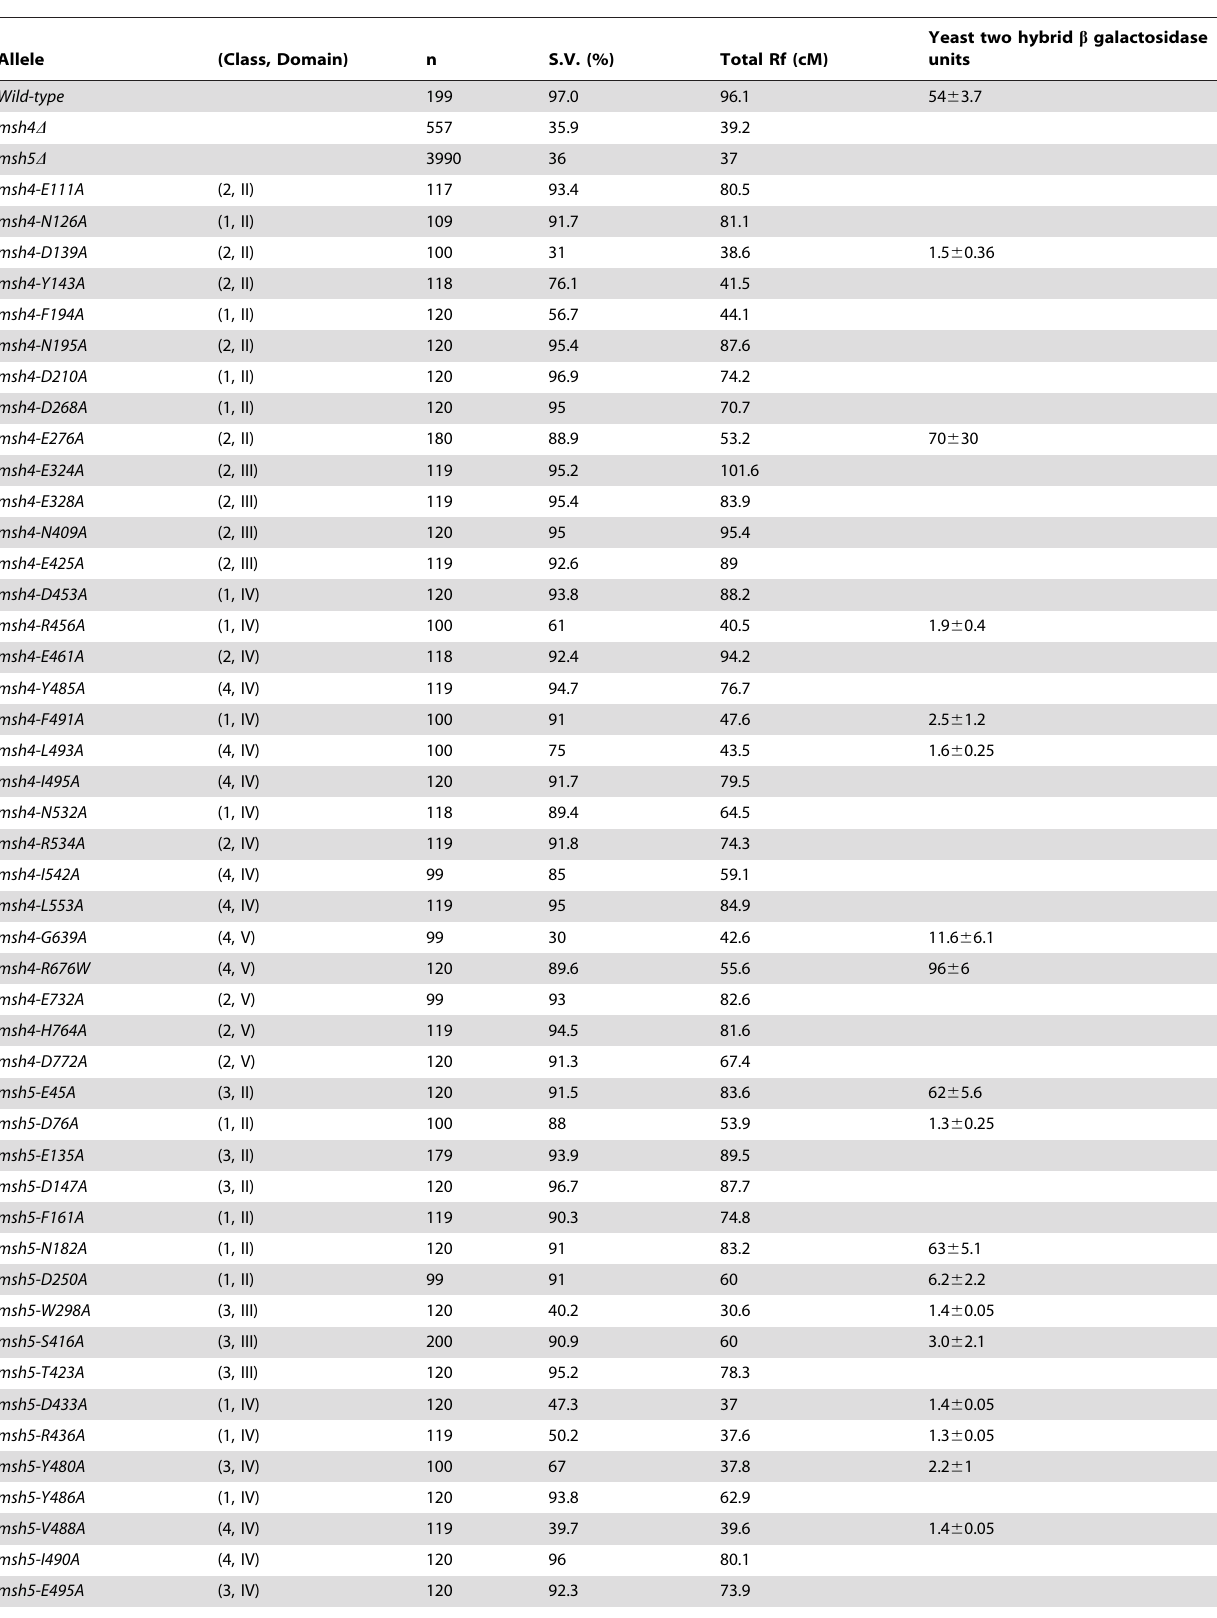
Table 1. Spore viability and genetic map distances in EAY1108/EAY1112 strains bearing the indicated msh4 and msh5 mutations.